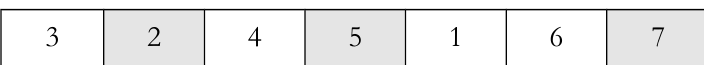
Figure 5. Given solution with three random selected positions